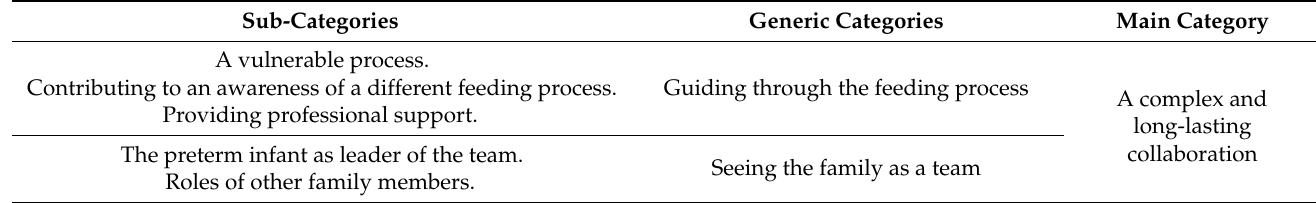
Table 1. Sub-categories, generic categories and main